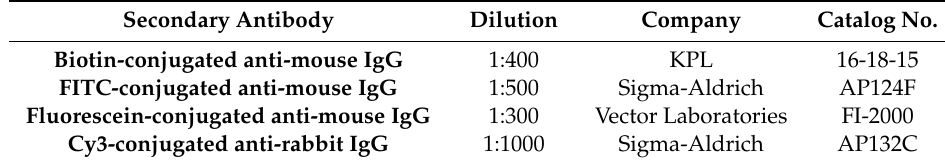
Table 2. Secondary antibodies used for IHC and